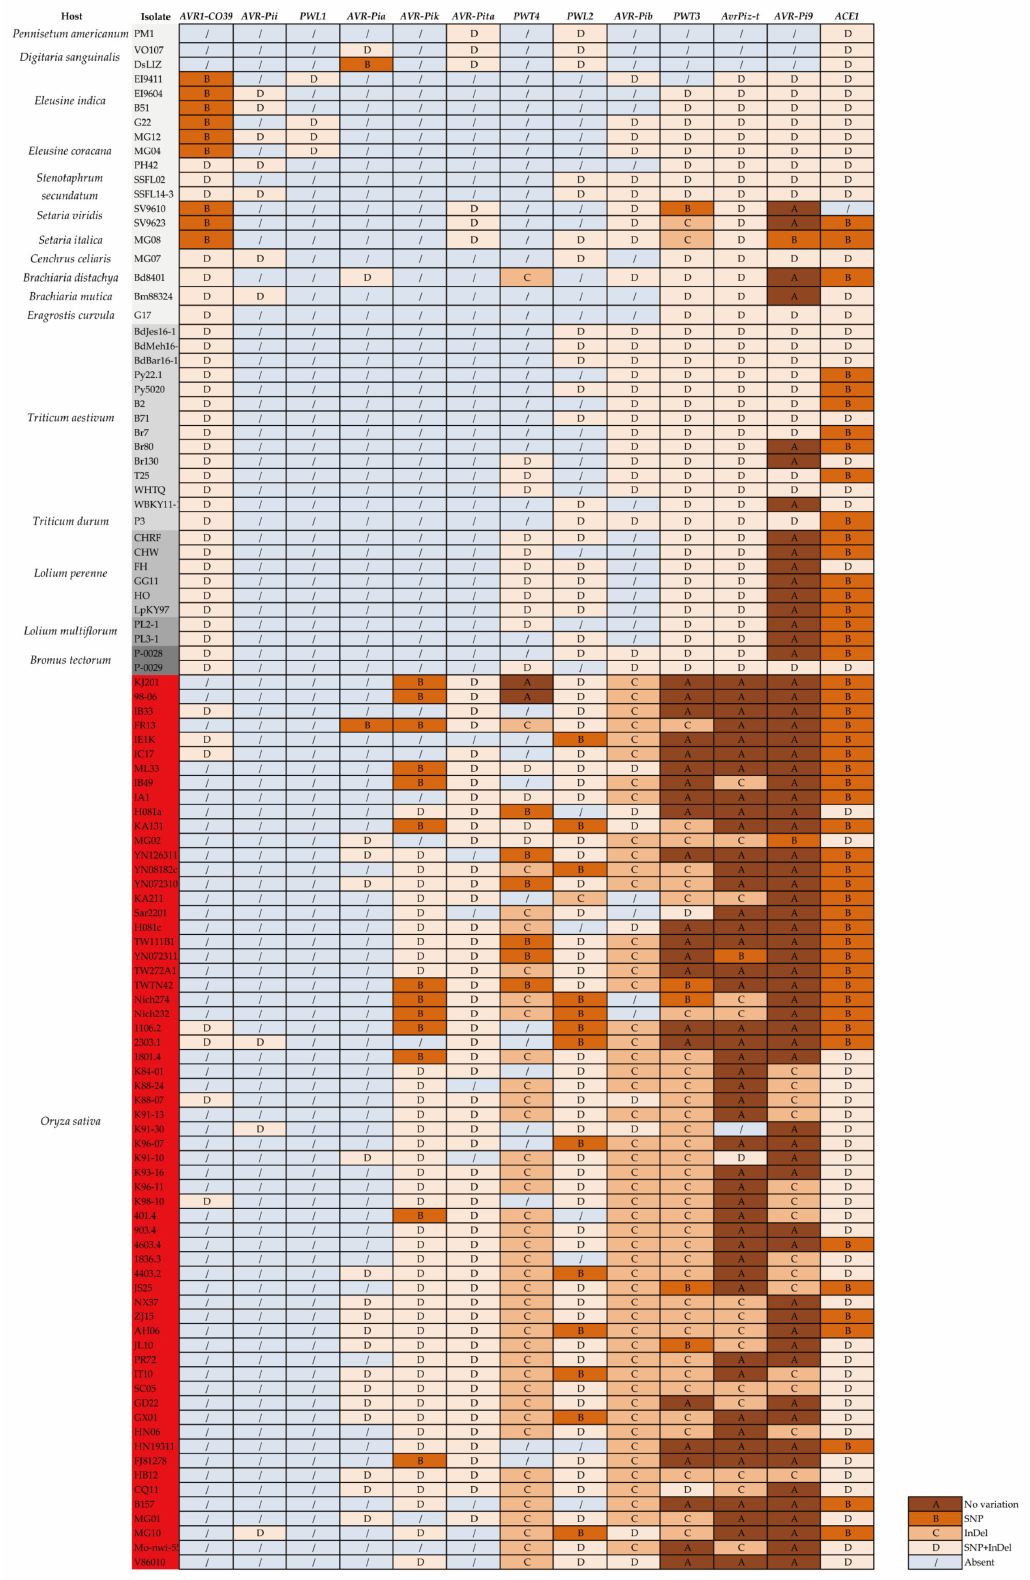
Figure 3. Highly polymorphic distribution of 11 cloned AVR genes in M. oryzae isolates from different hosts. The isolates with red color came from rice, and the gray from light to dark indicated wheat-, Lolium - and Bromus -infecting isolates. The other non-rice-infecting isolates were not filled with